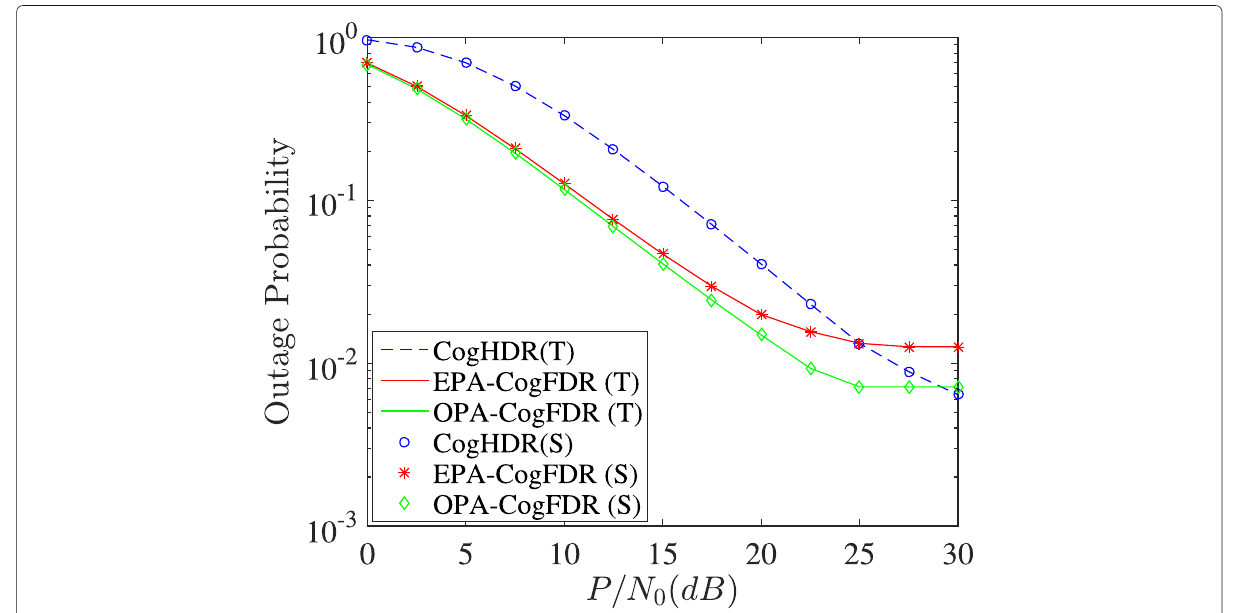
Fig. 11 Outage probability comparison with effect of interference from PT; P PT / N 0 = 10 dB